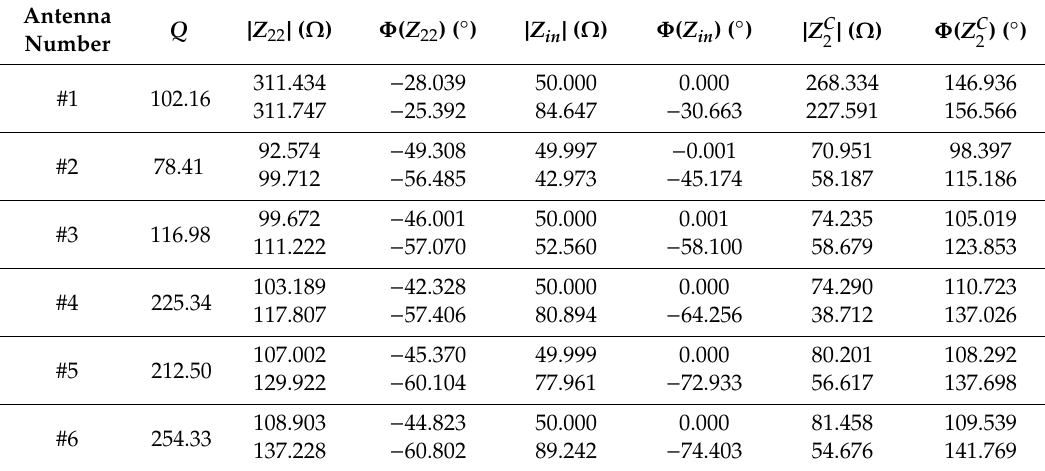
Table 3. Quality factor Q , amplitude and phase of Z 22 and Z in , and mutual coupling ( Z C of the antennas of Table 2. The upper value in each row is related to ε r = 1.000, the lower one to ε r = 1.025. The quality factor is determined at